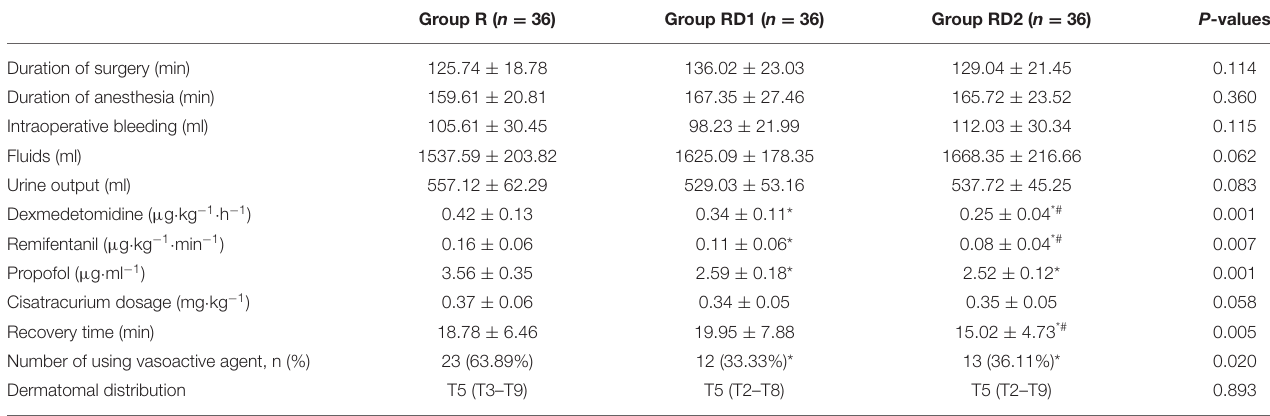
TABLE 2 | Intraoperative